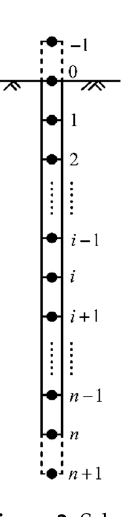
Figure 2. Schematic diagram of di ff erential dispersion of single pile after